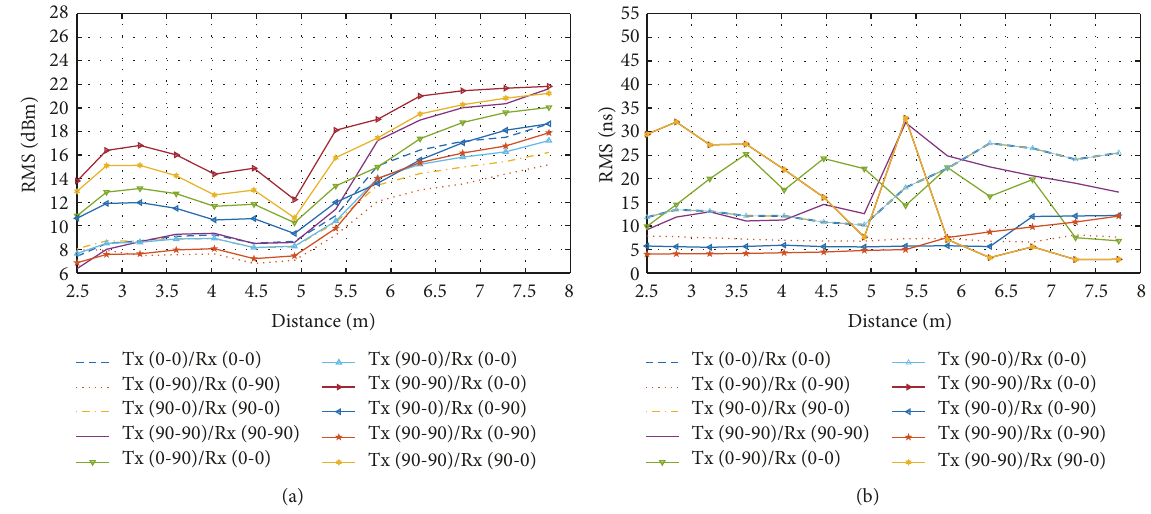
Figure 15: RMS delay spread for the two antennas in the OLOS scenario: (a) 3D cubic antenna and (b) dipole antenna.